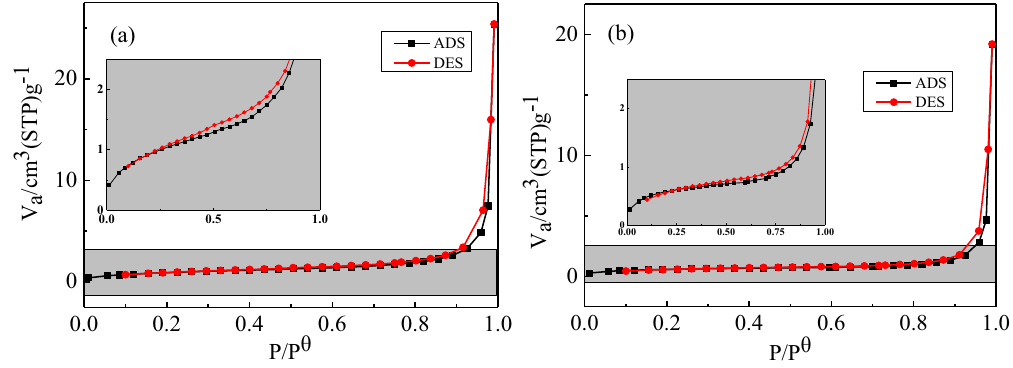
Figure 8: The adsorption – desorption curves of the products after pickling ( a ) 8# and ( b ) 6#.